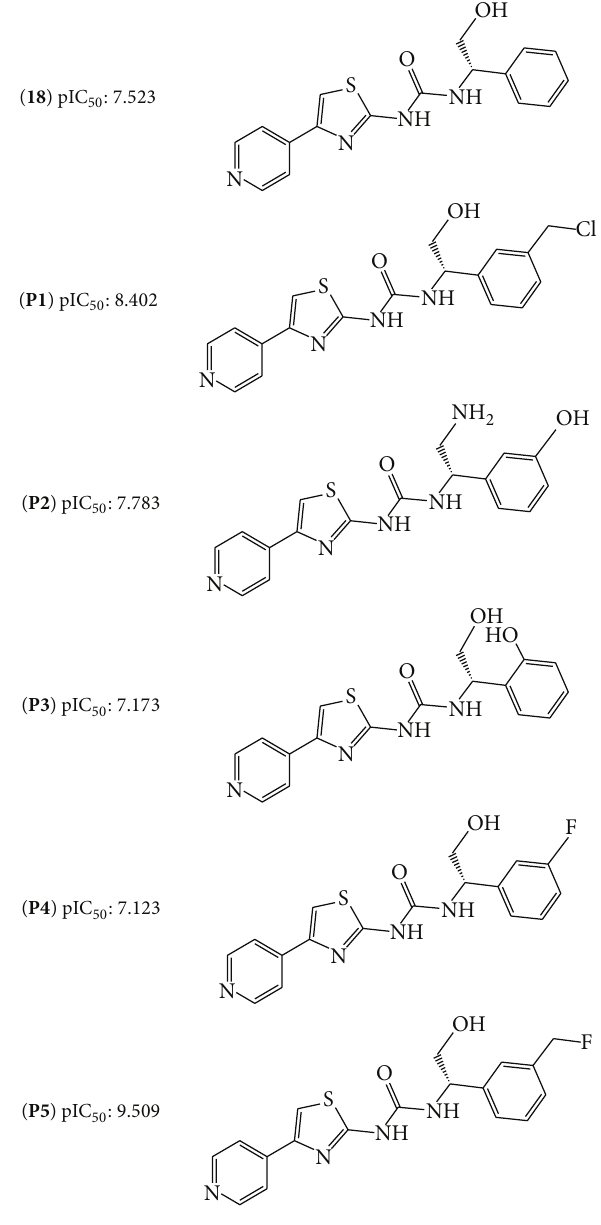
Figure 7: Structure of the proposals and the predicted pIC 50